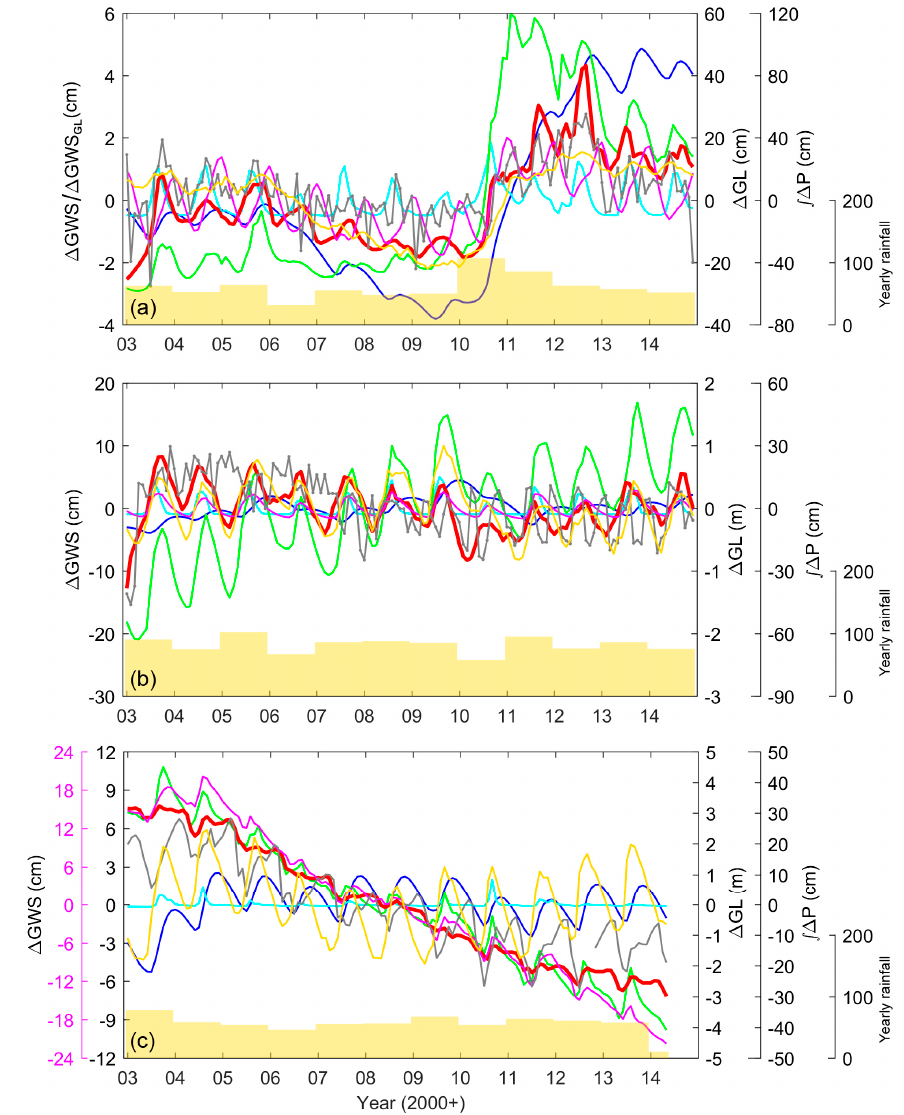
Figure 13. Same as Figure 12, but in VIC ( a ); PB ( b ); and NCP ( c ). For visualization purposes, the additional axis (magenta left axis) is displayed for the WGHM estimated Δ TWS in NCP ( c ).